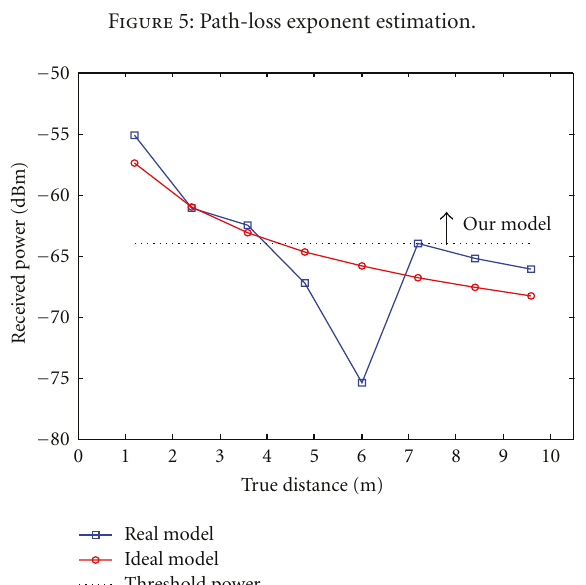
Figure 7: Histogram of distance estimation which corresponds to the true value of 1.2m.